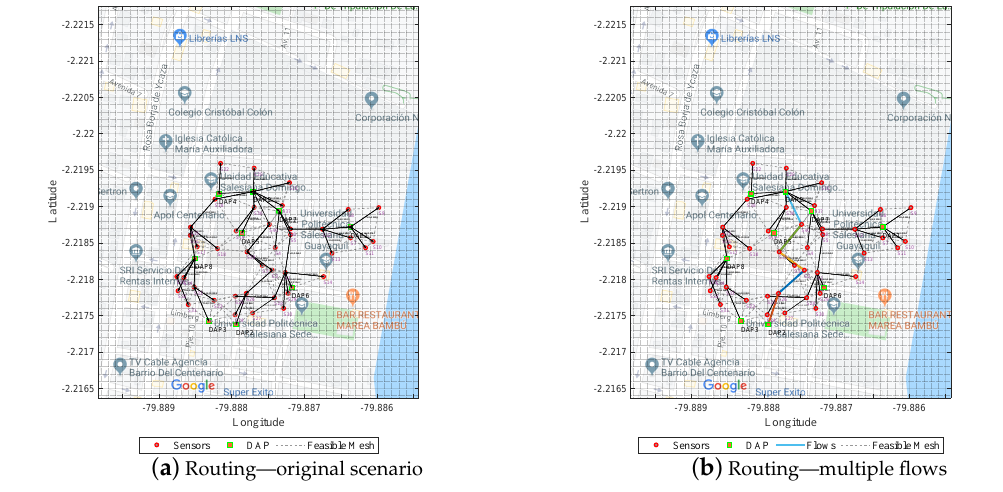
Figure 6. Optimal routing of wireless link—capacity link